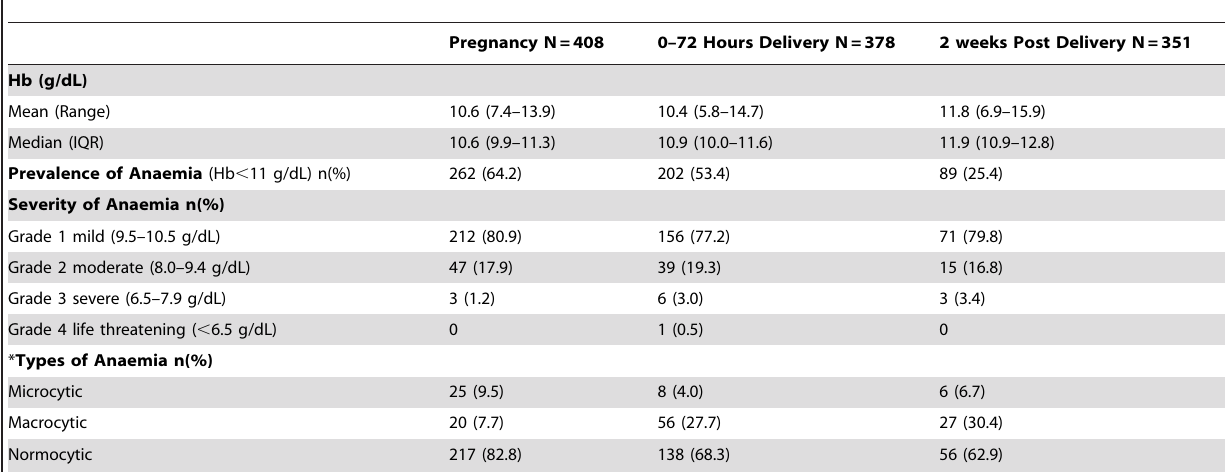
Table 1. Anaemia in pregnancy, within 72 hours of delivery and 2 weeks post delivery.